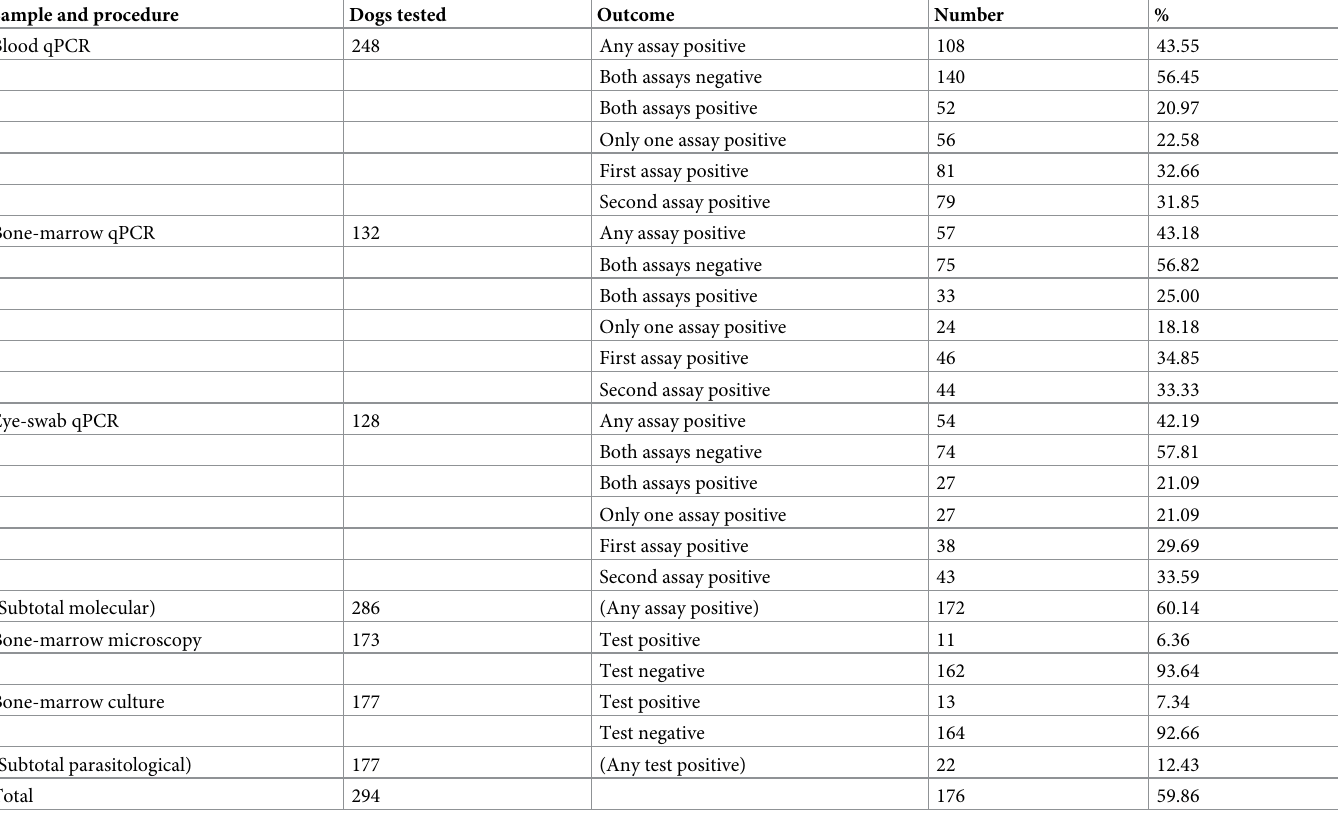
Table 5. Patterns of Leishmania detection/non-detection in dogs from central-western Brazil: Detailed results stratified by biological sample and diagnostic procedure. Sample and